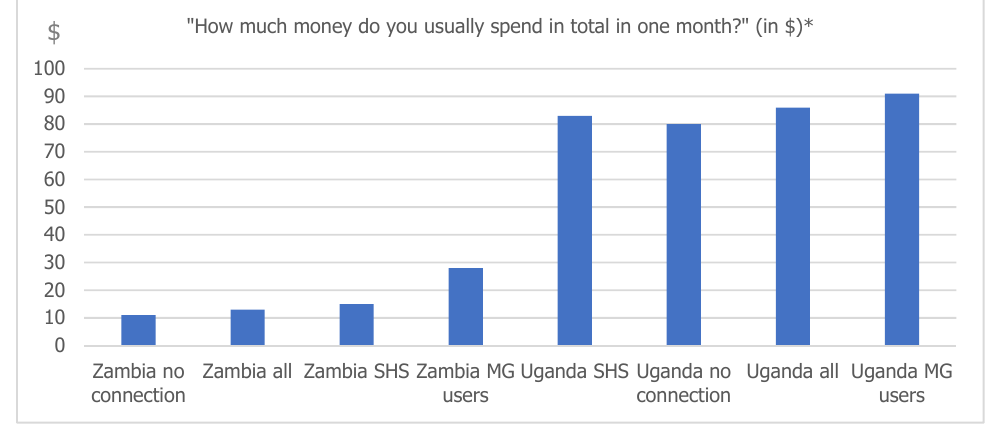
Figure 3. Average monthly spending levels of rural communities in Uganda and Zambia ( N = 1016; Responses in %; Multiple responses possible). * Based on currency exchange values of 2020.